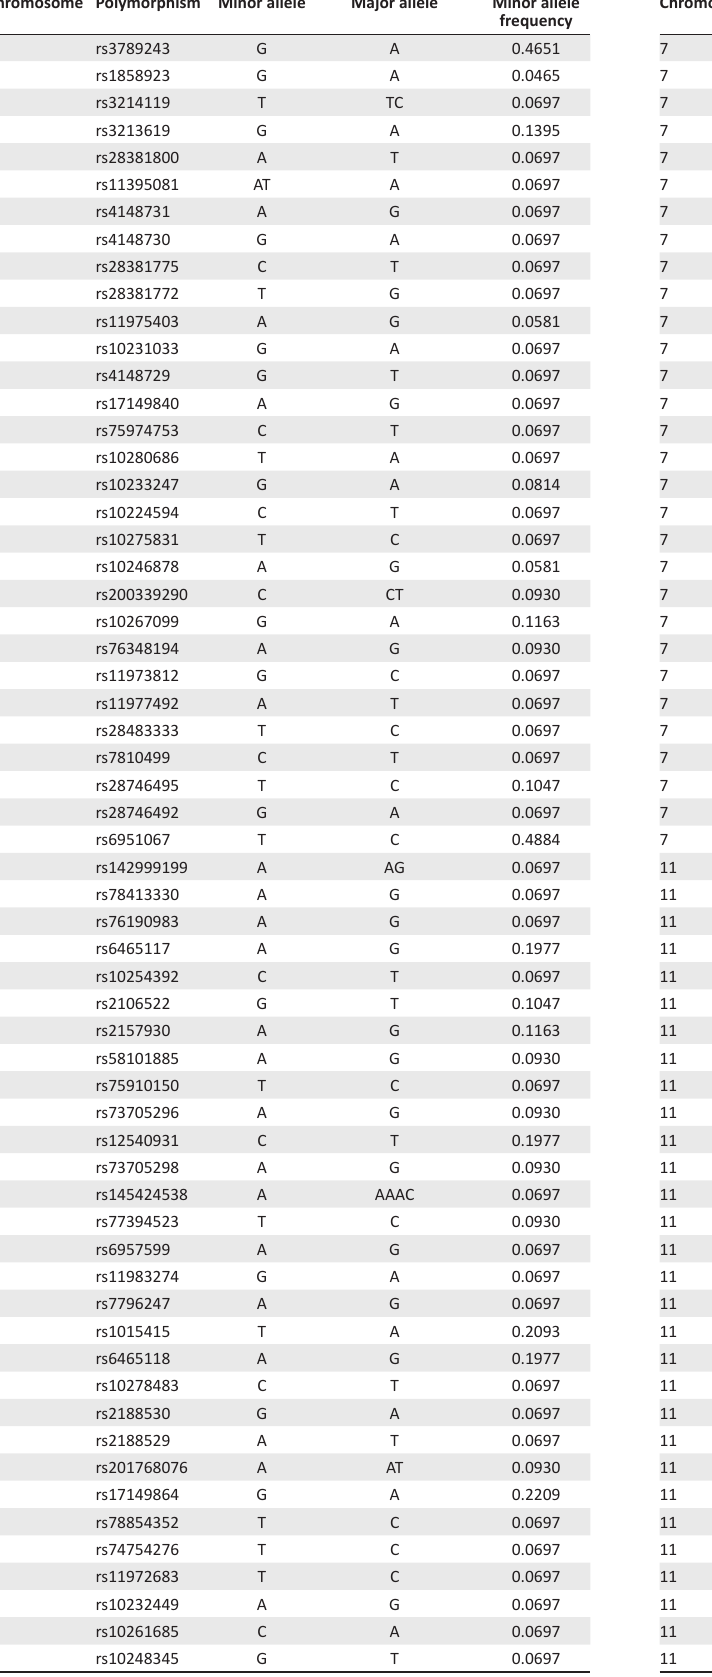
Table 1-A1 continues on the next page →Table 1-A1 continues in the next column